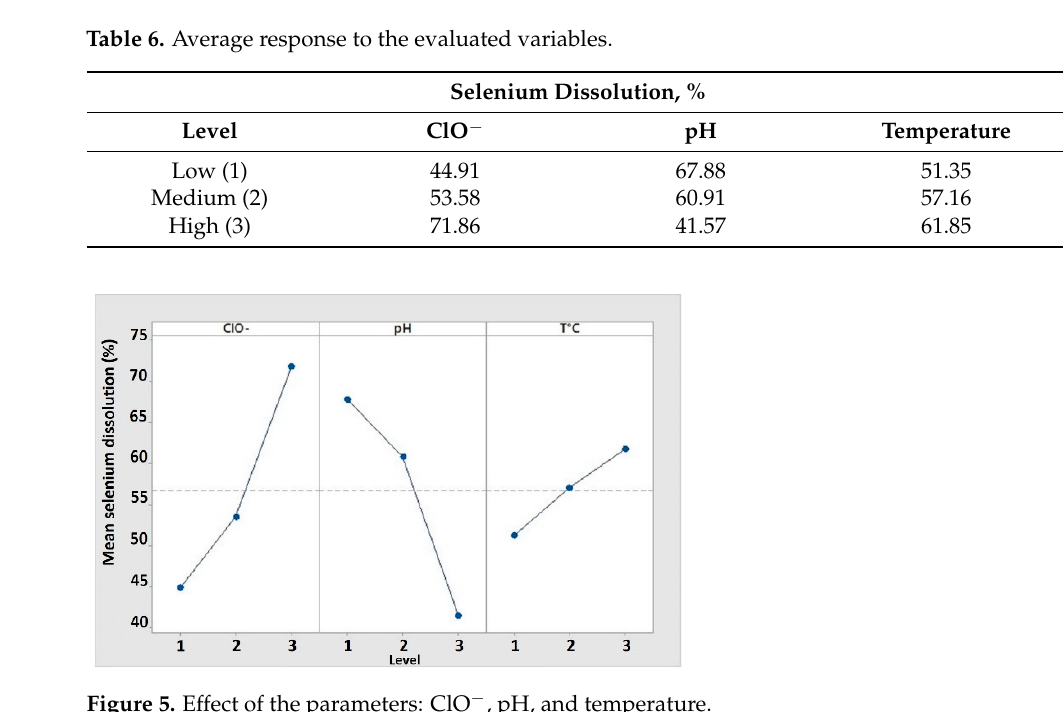
Figure 5. Effect of the parameters: ClO − , pH, and temperature.